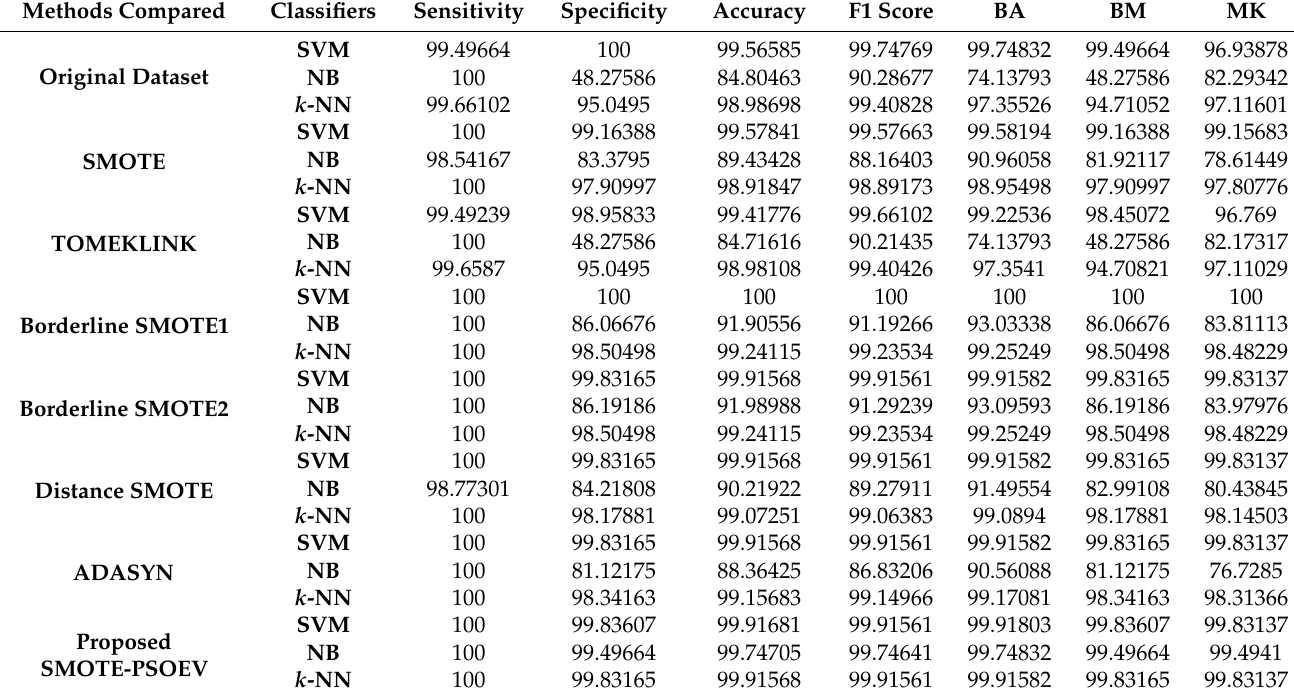
Table 6. Performance recognition (in %) of Segment0 dataset.